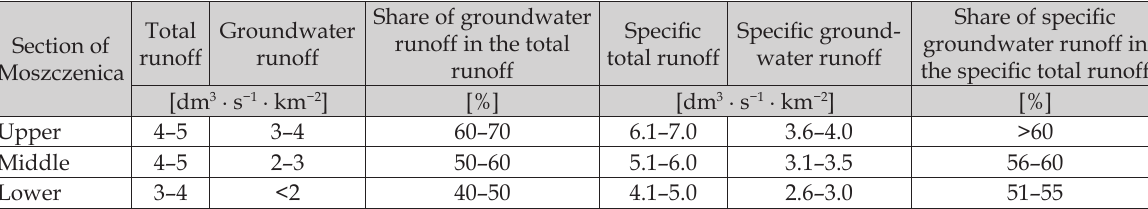
Table 1. Hydrological variation in the Moszczenica catchment (based on Jokiel 2004).